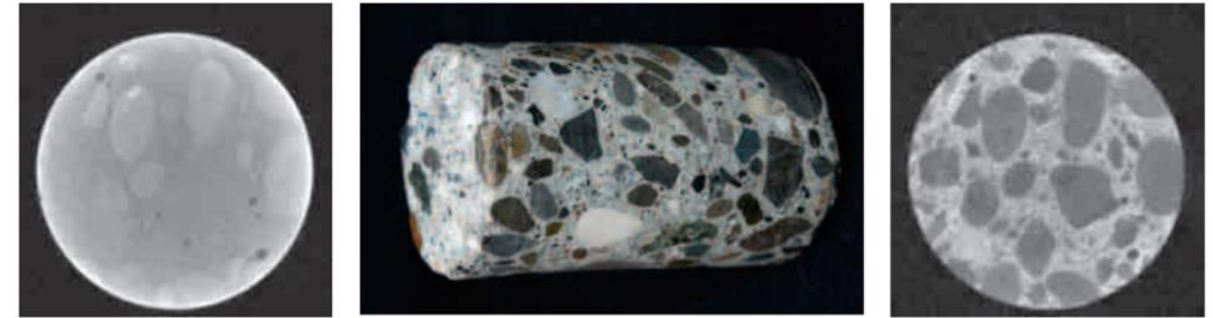
Figure 10. Core-drill of plain concrete—(from left to right ) section from X-ray tomography 120 kV, photograph, corresponding section based on neutron tomography. The sample diameter is 40 mm (image reprinted from ref. [23]).